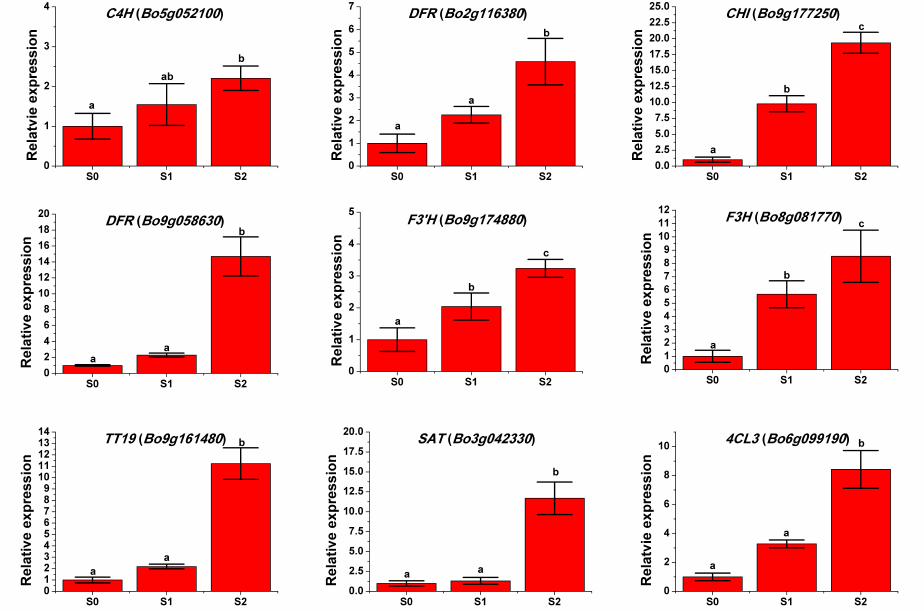
Figure 5. Expression levels of the DEGs related to anthocyanin biosynthesis at S0–S2. Data are represented as the mean ± standard deviation. Different lower-case letters indicate significant differences based on an analysis of variance (Tukey’s test, p ≤ 0.05).